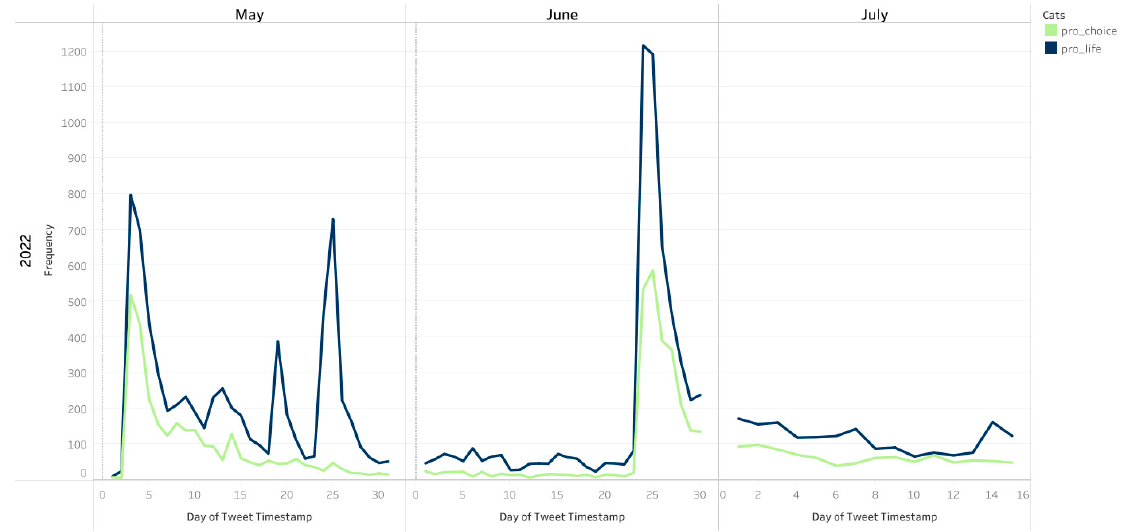
Figure 4. Number of pro-choice and pro-life tweets across 1 May–15 July 2022.